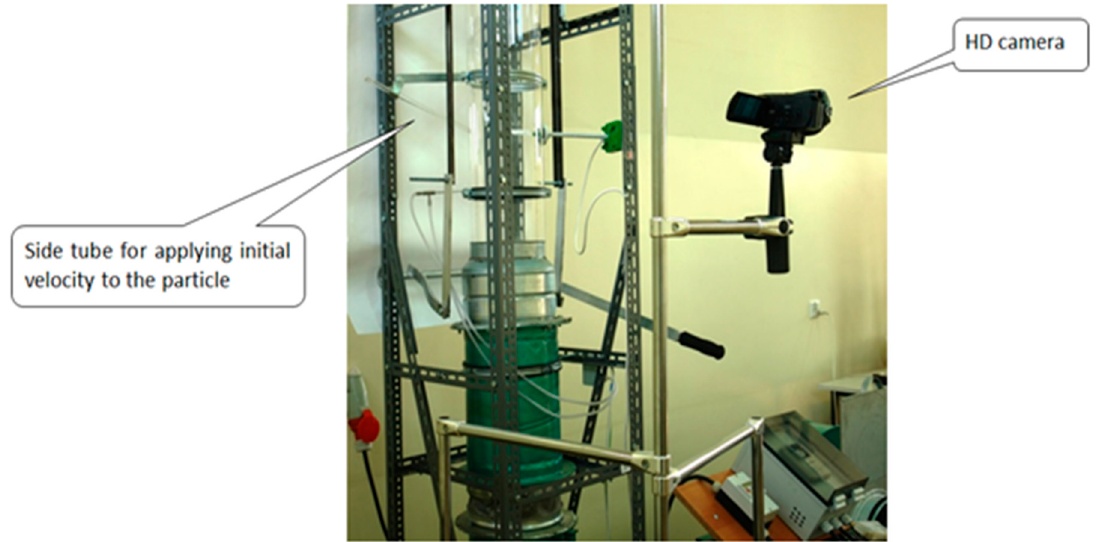
Processes 2021 , 9 , x FOR PEER REVIEW Figure 8. The setup for the measurement of the aerodynamic properties of solid particles.